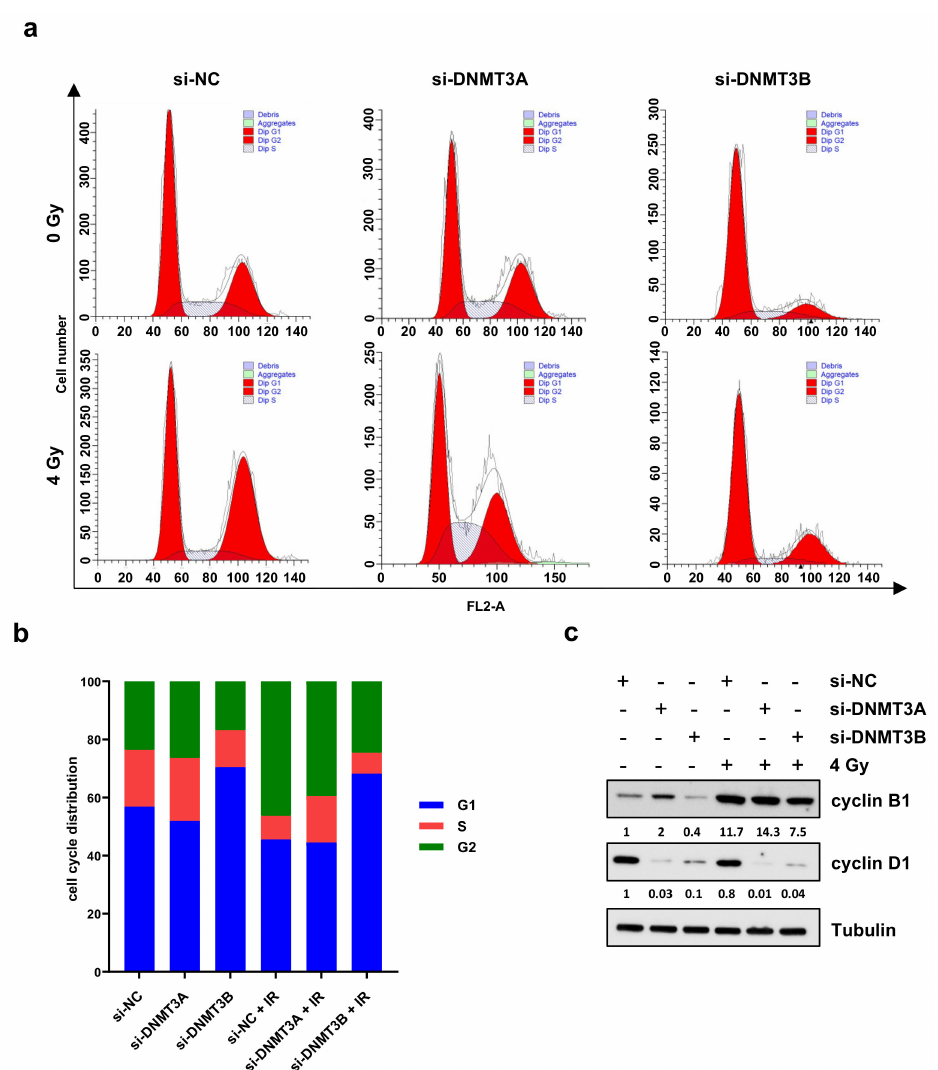
Figure 3. Cell cycle distribution of RD cells after DNMT3A and DNMT3B silencing and IR exposure. ( a ) Representative cell cycle distribution of RD cells at 24 h after irradiation and 72 h upon DNMT knocking down with the specific siRNAs. ( b ) Flow-cytometry assay-related bars showing cell percentage in G1, S, and G2 phases in RD cells silenced for DNMT3A or DNMT3B and exposed to radiation. Data are average value of four independent experiments. ( c ) Western blotting assays showing cyclin B1 and cyclin D1 levels in RD cells with or without specific siRNAs and IR. Tubulin was used as internal control. In Figure S1d are reported the densitometric analyses of the different experiments performed and the corresponding statistical